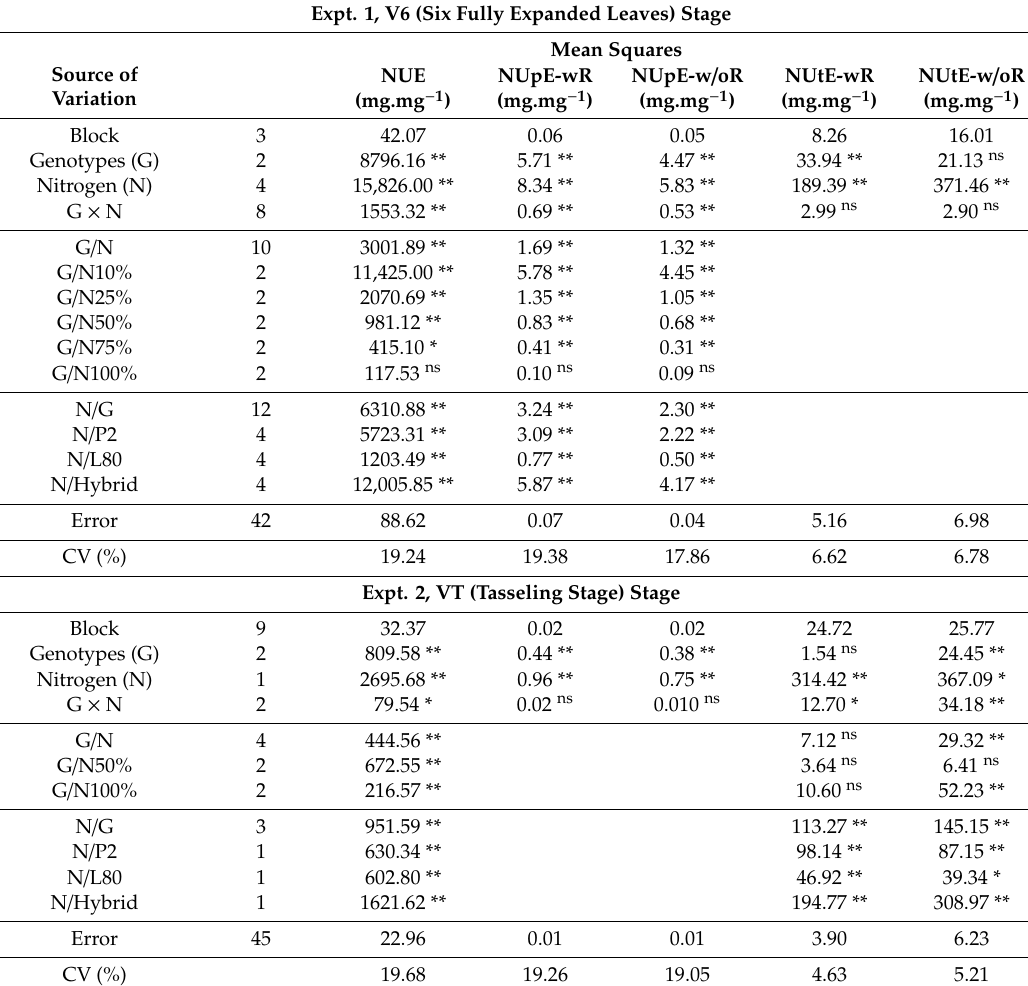
Table 4. Analysis of variance of popcorn genotypes (G), nitrogen levels (N) and G × N interaction for nitrogen use, uptake and utilization e ffi ciency at the V6 and VT